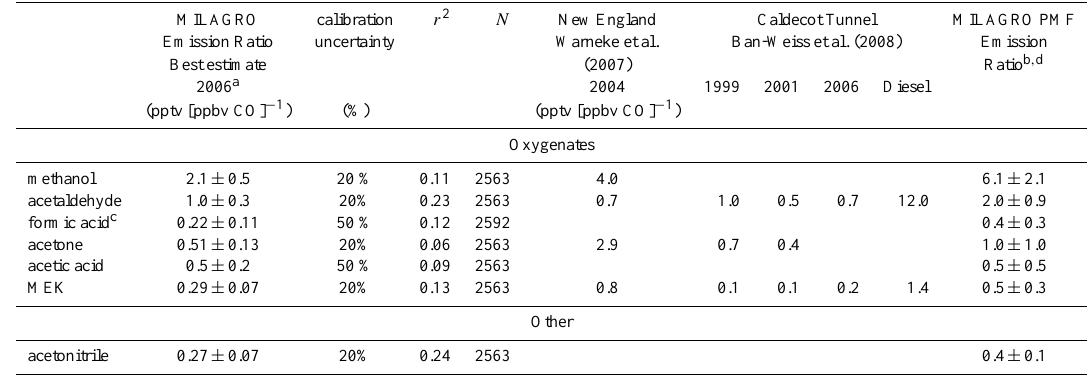
Table 4. Urban emission ratio estimates versus CO for OVOCs and acetonitrile calculated by linear regression and from MILAGRO mea- surements and from the results of PMF analysis. For comparison, literature values from PTR-MS measurements made in New England and from a US tunnel study are also shown. Methods used to calculate these values are discussed in detail in the text. Also shown are correlation coefficients ( r 2 ) and the number of points fit (N) . Reported errors for measurement-derived emission ratios are 1 σ uncertainties in the slope of the ODR fit. Uncertainties reported for the PMF-derived emission ratios were calculated using the method described in the text.